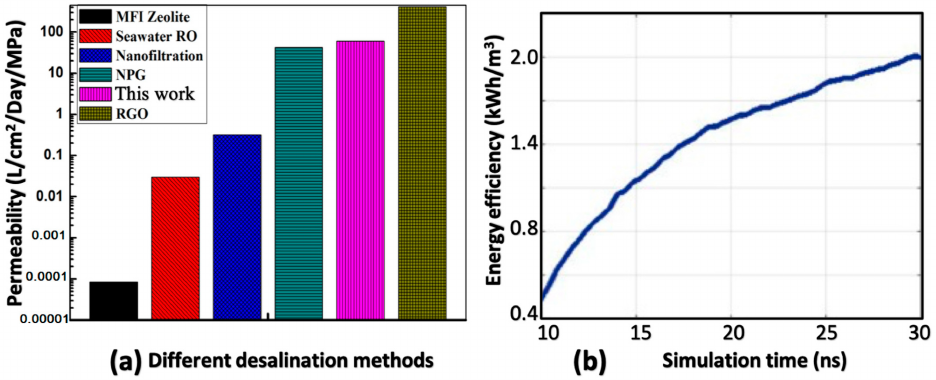
Figure 9. ( a ) Comparison of permeability of the current system with other RO materials. ( b ) Calculated energy efficiency as a function of simulation time, under ω = 35